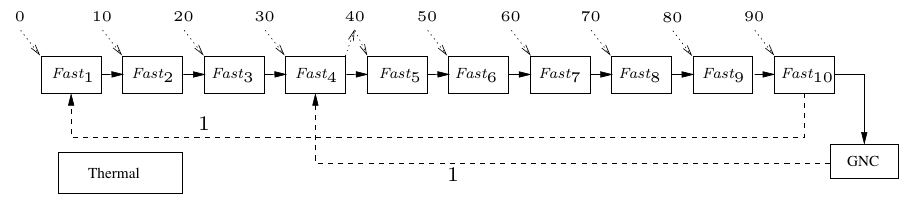
Figure 7 Real-time characterization of the Simple example (MTF = 100